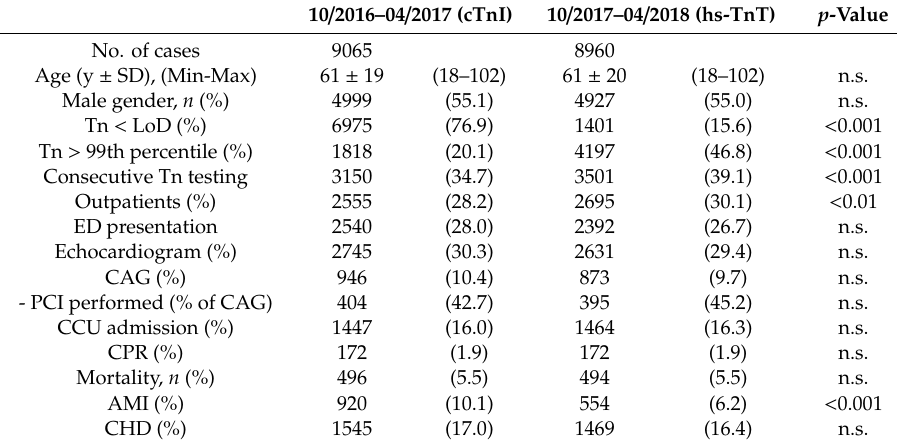
Table 1. Demographic and hospital data for all patients in the cohort (cTnI: conventional troponin I; hs-TnT: high-sensitivity troponin T; y: years; SD: standard deviation; Tn: troponin; LoD: limit of